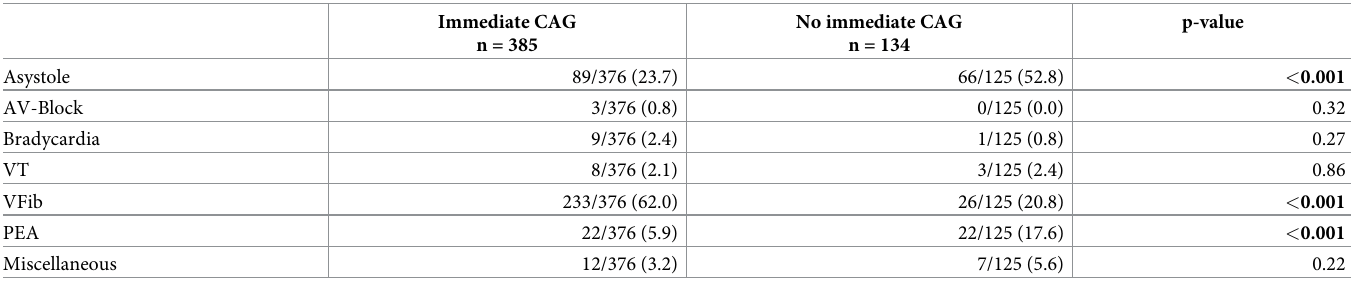
Table 2. Patients with and without immediate CAG according to initial